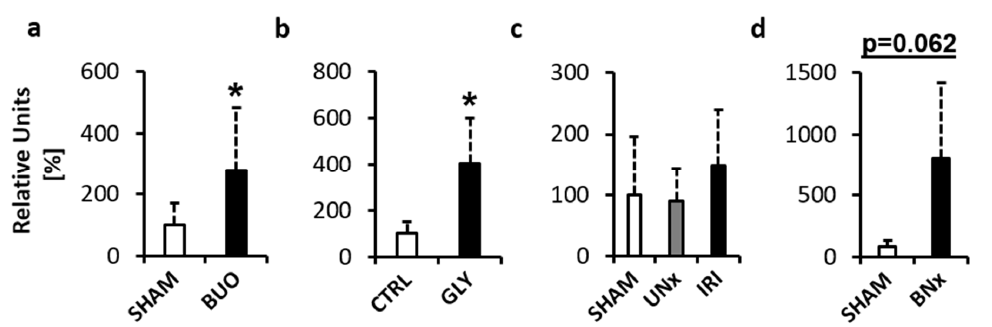
Figure 2. Total ecDNA measured in plasma of mice with acute kidney injury (AKI). ( a ) Bilateral ureteral obstruction. ( b ) Glycerol-induced AKI. ( c ) Ischemia–reperfusion injury. ( d ) Bilateral nephrectomy.* denotes p < 0.05. Data are presented as mean + SD. BUO—bilateral ureteral ligation,